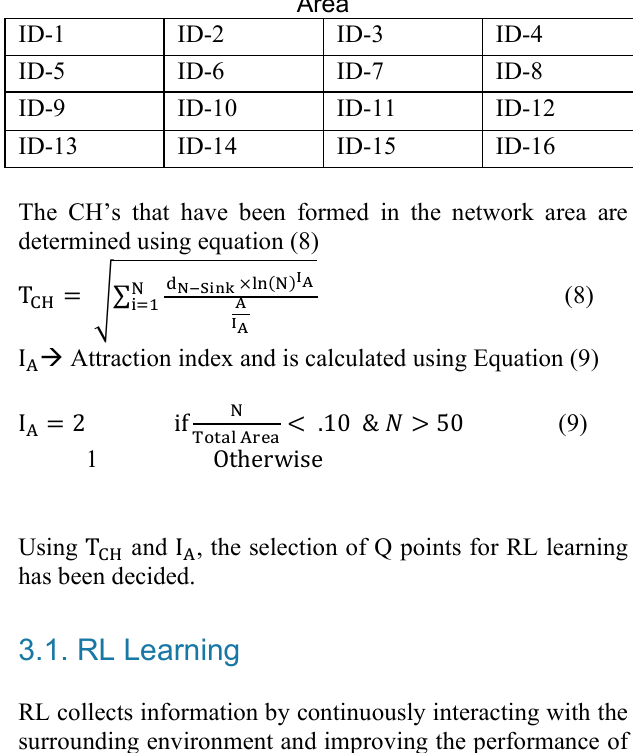
Table 3. Cluster Identification for 1600×1600 Network